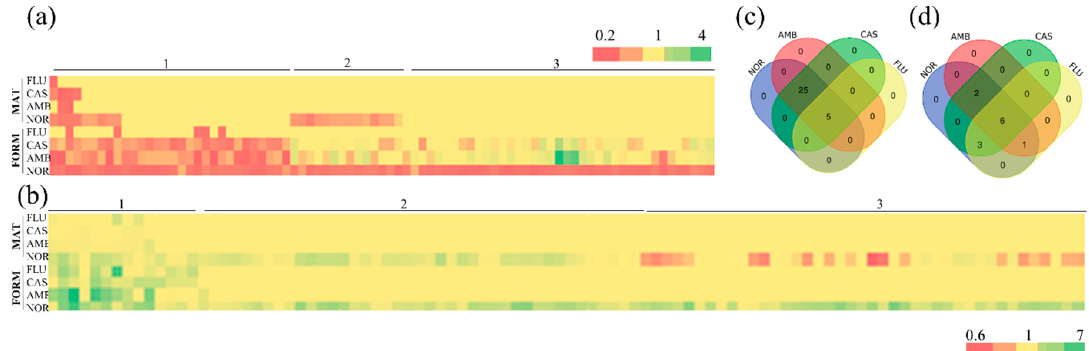
Figure 1. Identification of sensitive and tolerant mutants: heat maps of sensitive ( a ) and tolerant ( b ) mutants identified in the screening based on the growth phenotypes (GPs). Values of the GPs ratios (mutant vs. wild type control) recorded in the screening are reported at the bottom of the map. Each row represents a drug treatment (nortriptyline (NOR), amphotericin B (AMB), caspofungin (CAS), and fluconazole (FLU)) during biofilm formation (FORM) or on a mature biofilm (MAT). Three groups were identified: mutants sensitive or tolerant to more than one drug (1), sensitive and tolerant to NOR during biofilm formation or maturation (2), and sensitive and tolerant only during biofilm formation (3). The Venn diagrams presented in ( c ) and ( d ) analyze in more detail the overlap between the given GPs upon drug treatments of sensitive or tolerant mutants.